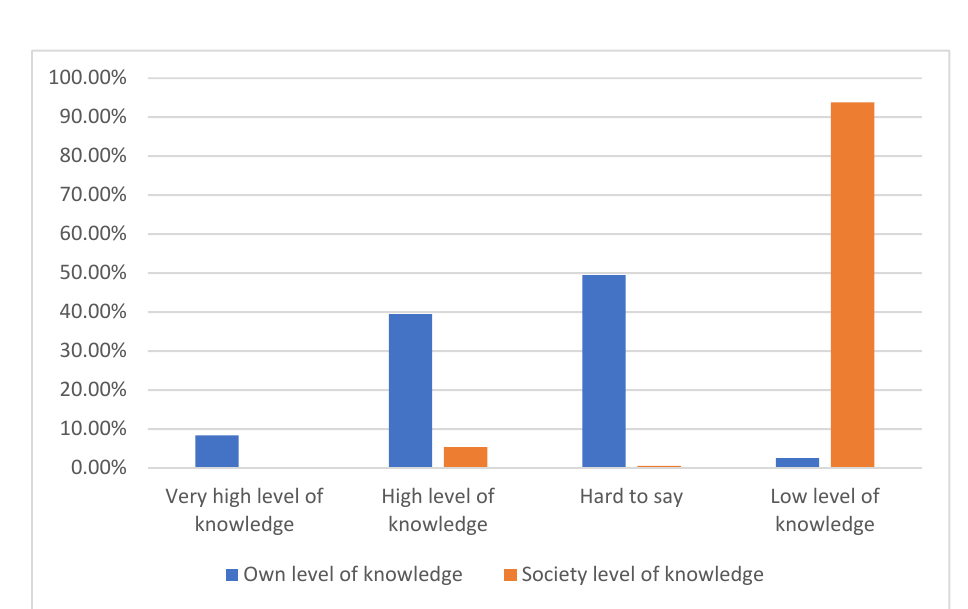
Figure 1. The assess of the level of knowledge about mental disorders.